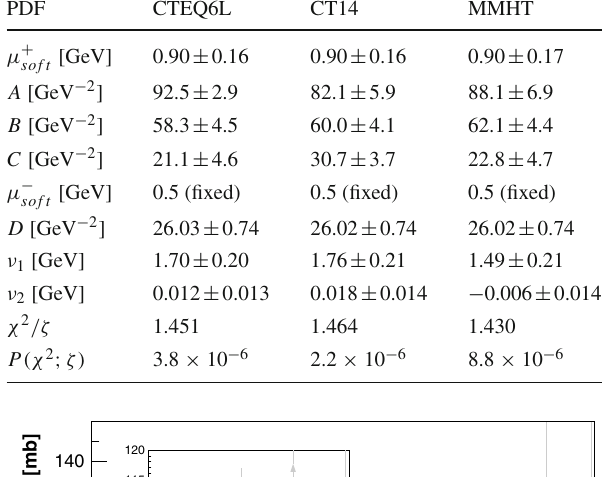
Table 6 Best-fit parameters of our model with low-energy cut-off √ s min = 5.0 GeV. The number of degrees of freedom is ζ = 251